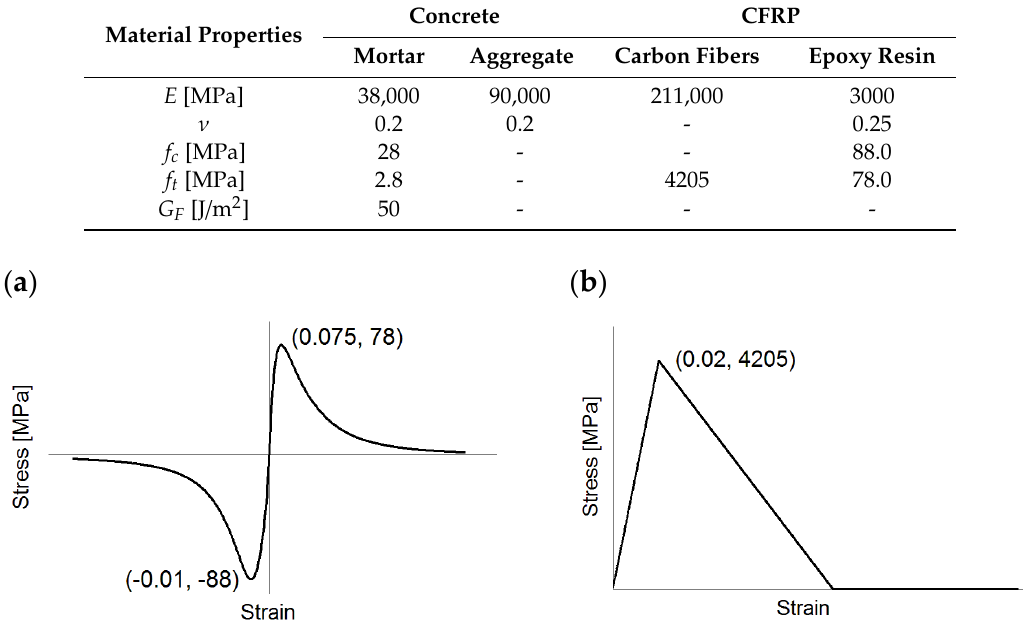
Figure 3. Constitutive law for: ( a ) Epoxy resin and ( b ) fibers (adapted from